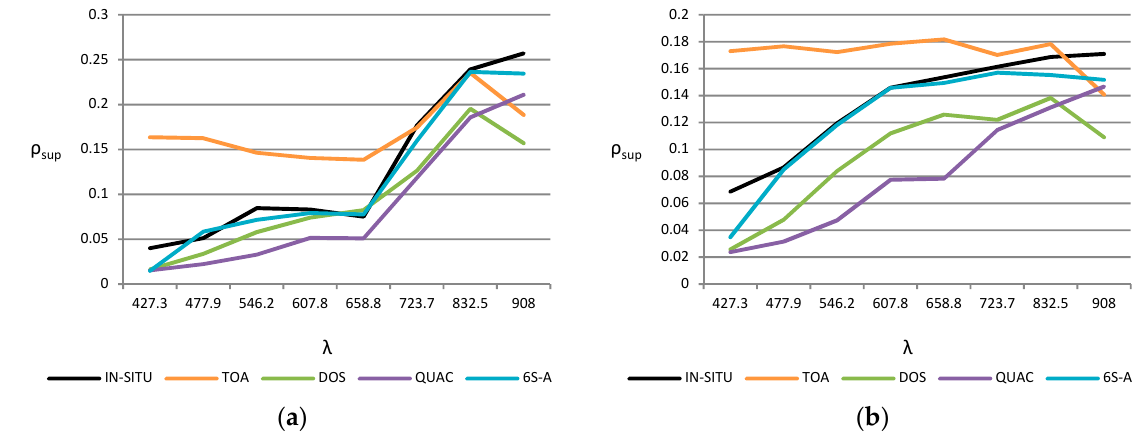
Figure 8. In situ, TOA and corrected spectral reflectivity signatures applying DOS, QUAC and 6S methods (A scenario): ( a ) vegetation point; ( b ) bare soil point.